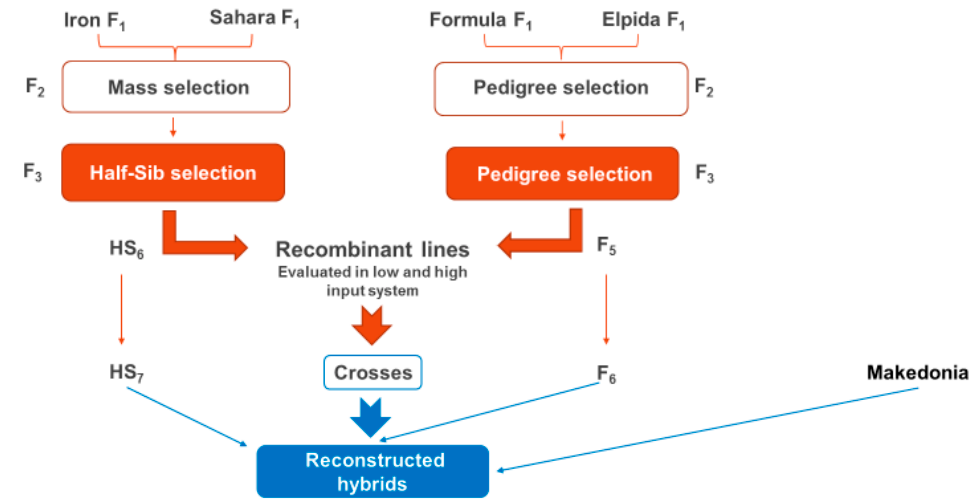
Figure 1. The breeding process that was applied for the production of new recombinant lines and reconstructed hybrids.